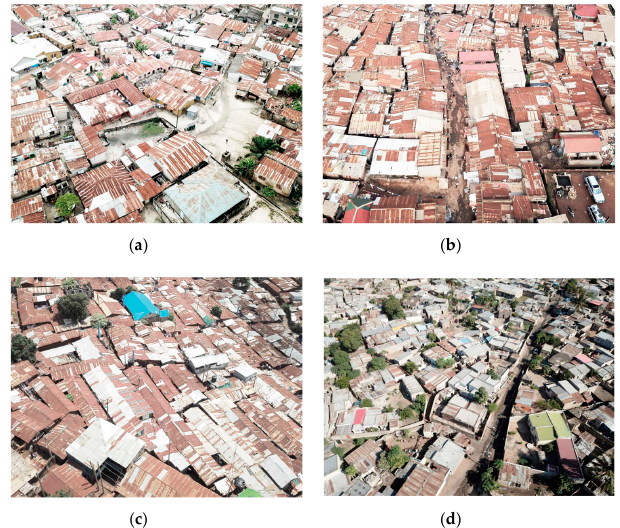
Figure 3. Aerial views of case study areas: ( a ) Hananasif, Dar es Salaam, Tanzania; ( b ) Katanga, Kampala, Uganda; ( c ) Kibera, Nairobi, Kenya; and ( d ) Maxaquene A, Maputo, Mozambique. Table 4. Indicators of urban form for the four surveyed